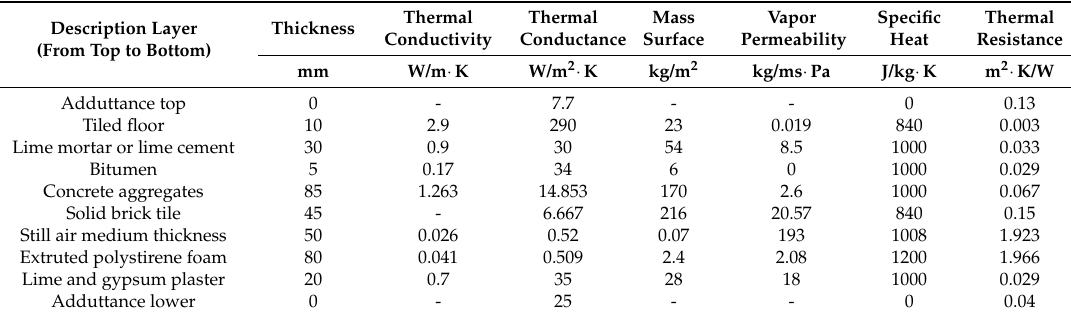
Table 3. Villa Sciarra floor stratigraphy after intervention.